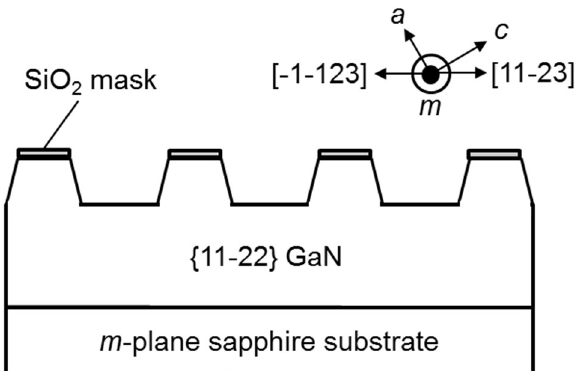
Figure 3. A schematic illustration of the trench-patterned {11-22} GaN template with a SiO 2 mask on the terraces.